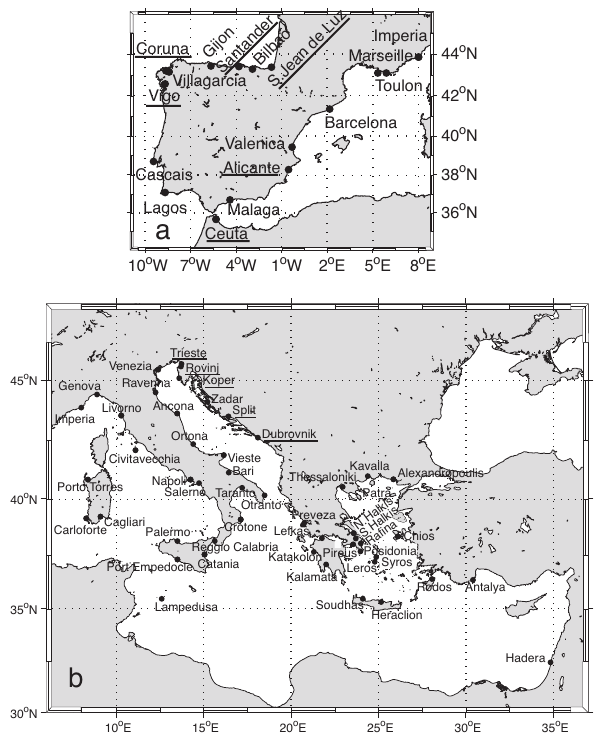
Figure 1. The location of the tide gauges used in this study. The geographical coordinates of the stations are given in Table 1. The underlined tide gauge stations are used in the analysis of the time series of percentiles.